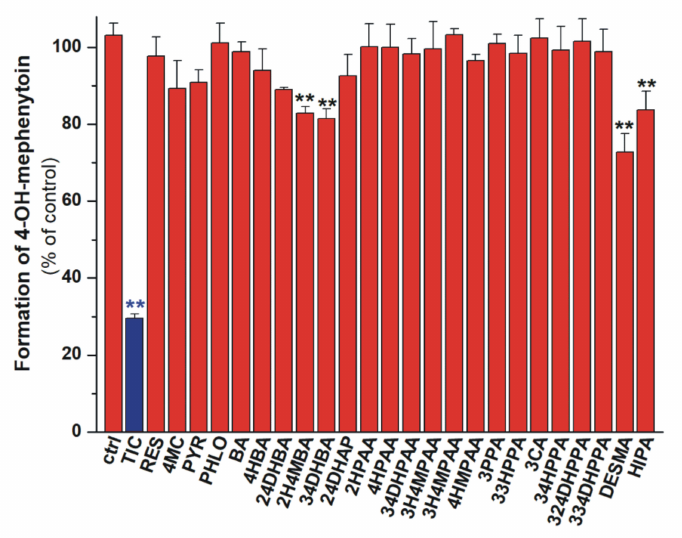
Figure 7. Inhibitory e ff ects of colonic flavonoid metabolites and ticlopidine (TIC,